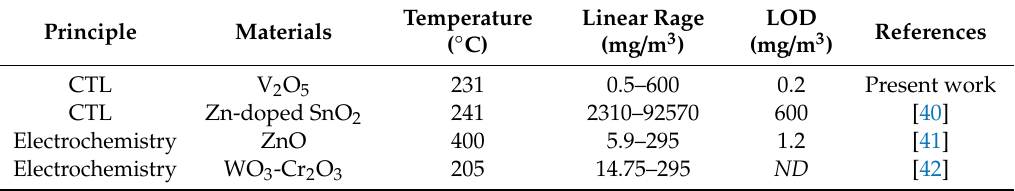
Table 2. Comparison of the gas sensing characteristics of sensors for 2-butanone based on different materials.